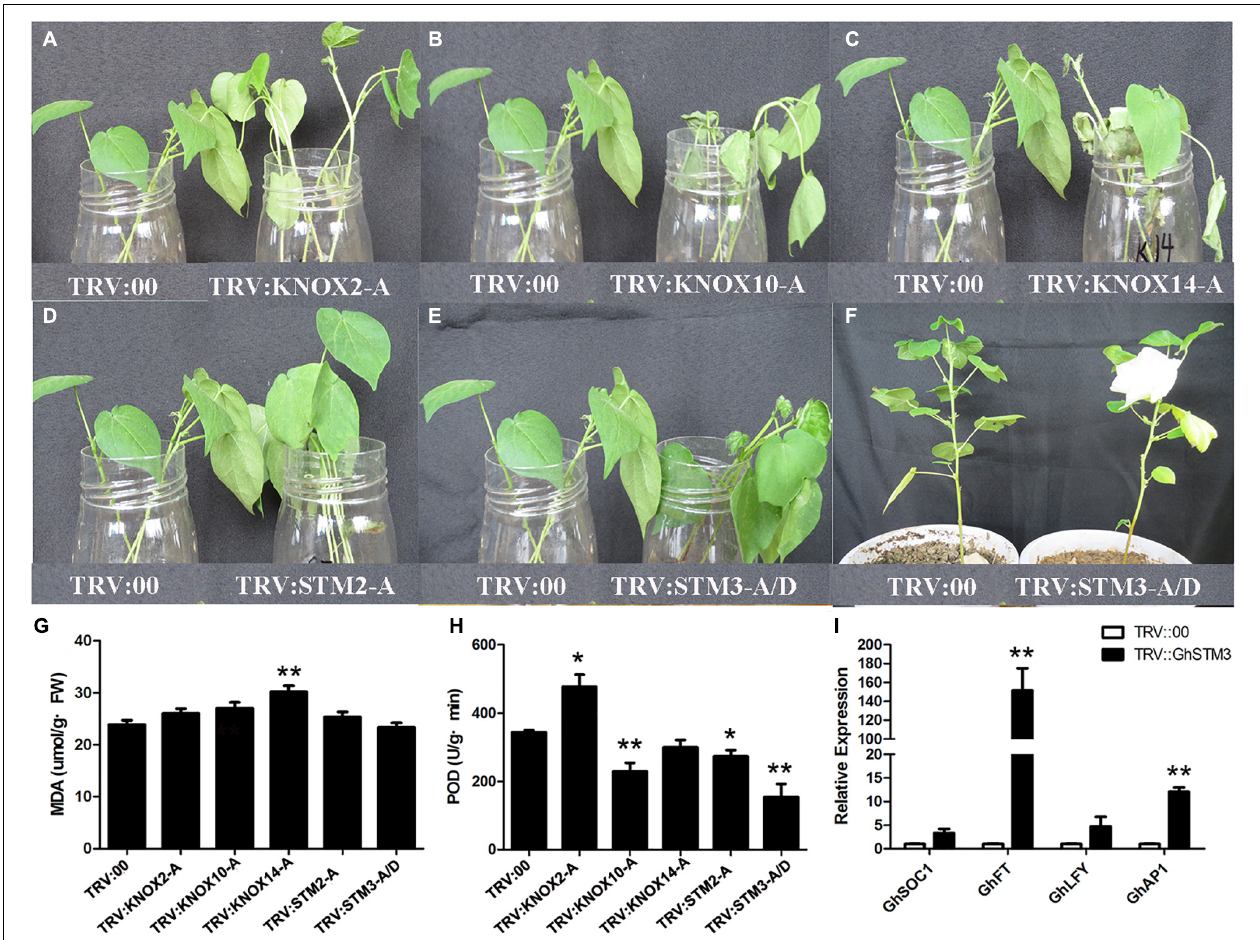
FIGURE 8 | VIGS analysis of five G . hirsutum KNOX genes. (A–E) The left-hand plant is the control cotton transformed with the empty vector. In the right-hand plants, GhKNOX2 - A , GhKNOX10 - A , GhKNOX14 - A , GhSTM2 - A , and GhSTM3 - A / D were silenced, respectively. (F) The control plant and GhSTM3 -silenced plant of ‘CCRI50’ from left to right. (G) Malondialdehyde (MDA) content in TRV:00 and plants silenced for five G . hirsutum KNOX genes. (H) Peroxidase (POD) activity in TRV:00 and plants silenced for five G . hirsutum KNOX genes. (I) Relative expression levels of GhSOC1 , GhFT , GhLFY , and GhAP1 . The significance of differences was determined using Student’s t -test (* P < 0.05, ** P <